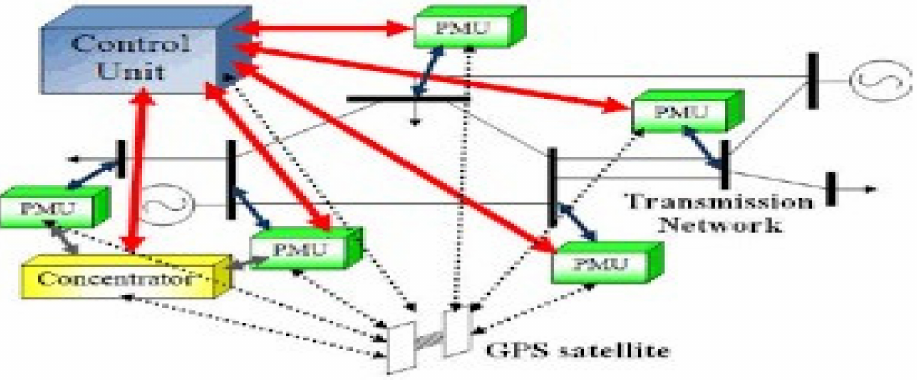
Figure 5. The hierarchical structure of a WAMS.